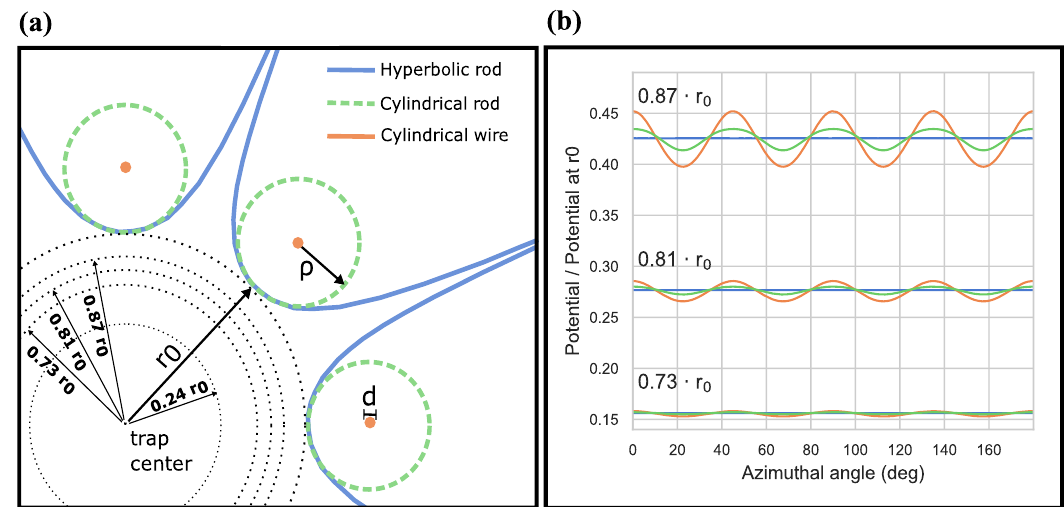
Figure 3. Comparison between different multipole traps. ( a ) True size relations between hyperbolic rods, ideal cylindrical rods, and cylindrical wires are represented. The distance of a hyperbolic rod from the trap center is r 0 = 2.25 mm, the diameter of an ideal cylindrical rod is 2 ρ = 1.5 mm and the wire diameter is d = 100 µm. The wires are placed concentrically with the ideal cylindrical rods and are located 3 mm from the trap center. ( b ) The effective potential created by hyperbolic rods is shown along with that obtained from a rod and a wire trap with their voltages matched to the same average potential as in the hyperbolic case. It can be seen that the hyperbolic trap potential exhibits true azimuthal angle independence, while distinct maxima/minima in the potential for traps with cylindrical rods or wires can be observed. Additionally, the modulations in a wire trap have a higher amplitude than those in a rod trap. For instance, the amplitude of fluctuations in a rod trap at 0.87 · r 0 is already attained by a wire trap at 0.81 · r 0